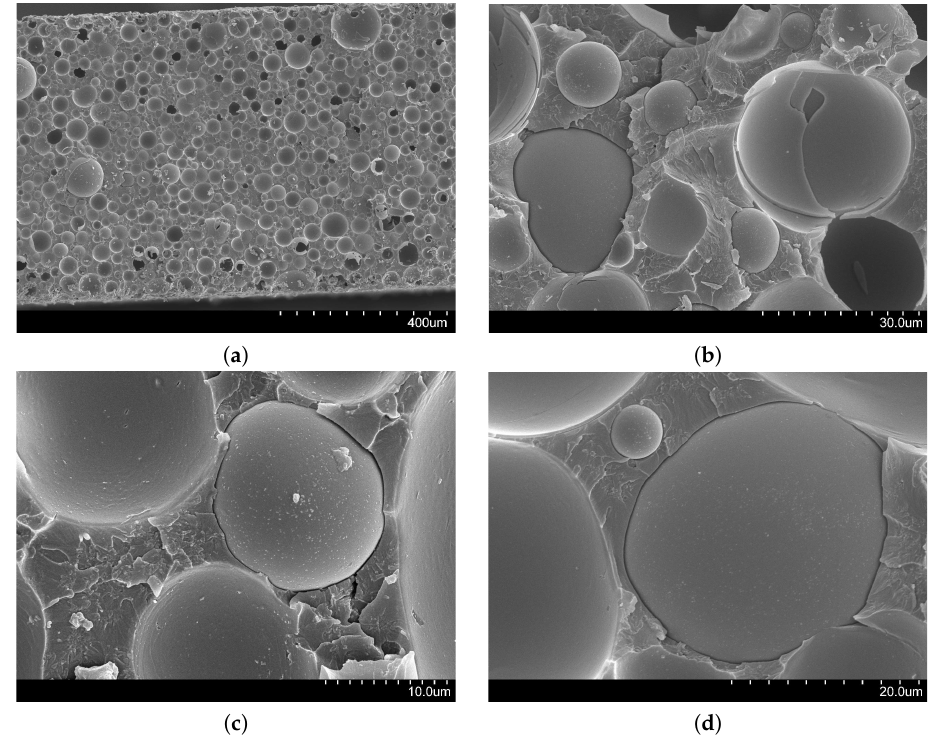
Figure 10. Fracture features of a failed VE220-60 panel: ( a ) Micrograph of the entire cross-section; ( b ) Magnified view of the top edge; ( c ) Magnified view of the bottom edge; and ( d ) Magnified view of the